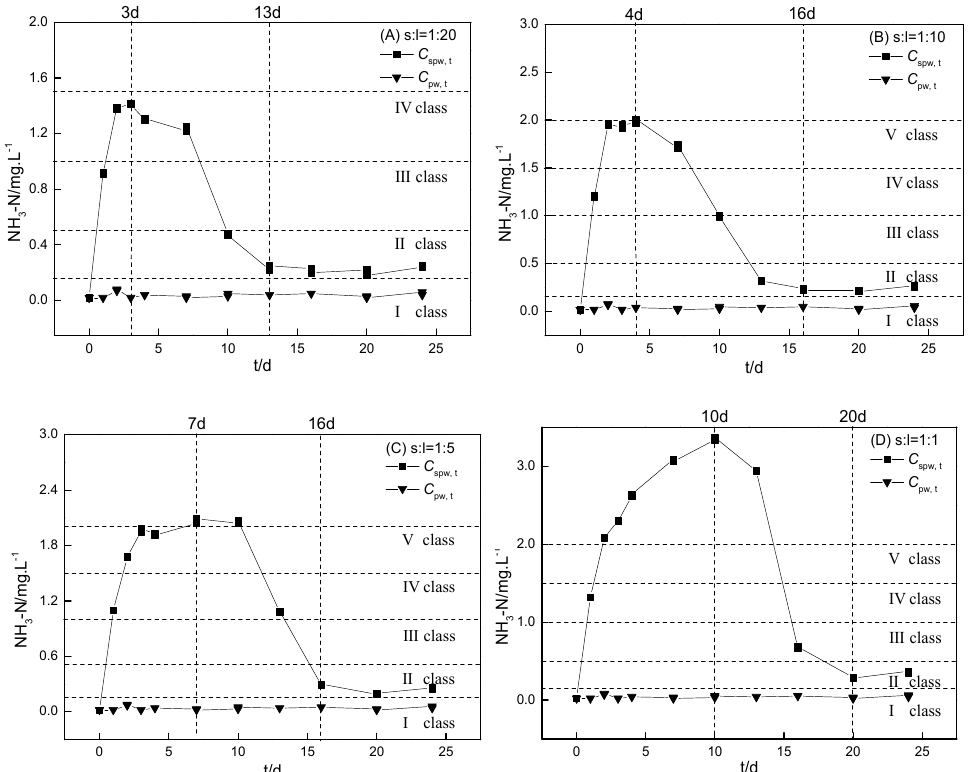
Figure 2. Kinetics of ammonium release from sediment (S1) incubation at different sediment-to-water ratios in ultrapure water ( C spw, t ). The sediment-to-water ratios for ( A ), ( B ), ( C ), and ( D ) were 1:20, 1:10, 1:5, and 1:1, respectively. The controls were the kinetics of ammonium incubation in ultrapure water ( C pw, t ) without sediments.